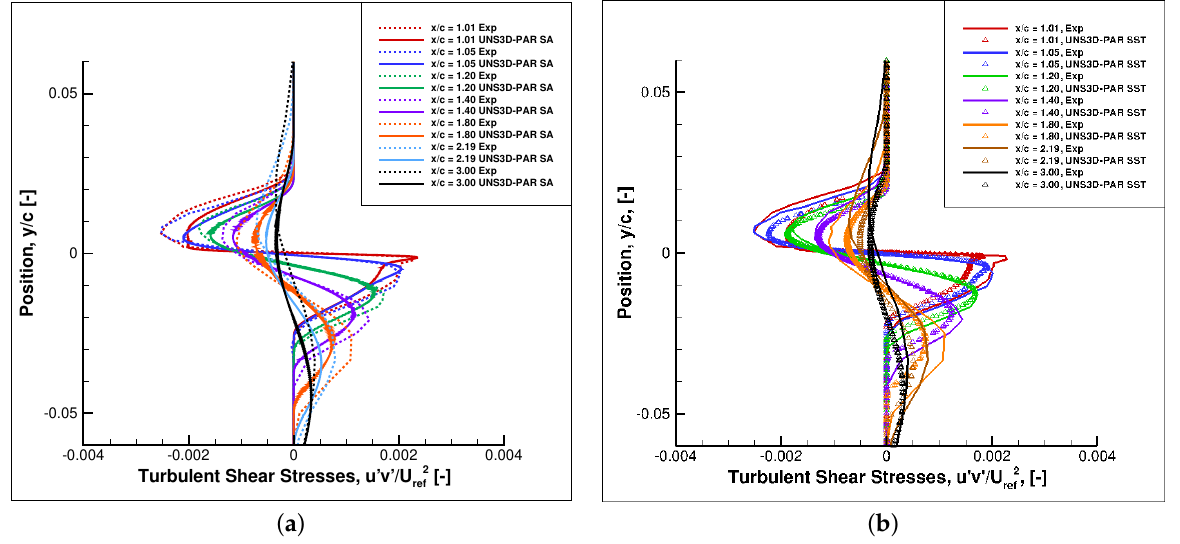
Figure 16. Dimensionless turbulent shear stress profiles on Nakayama’s airfoil: ( a ) Spalart–Allmaras, and ( b ) Shear Stress Transport.